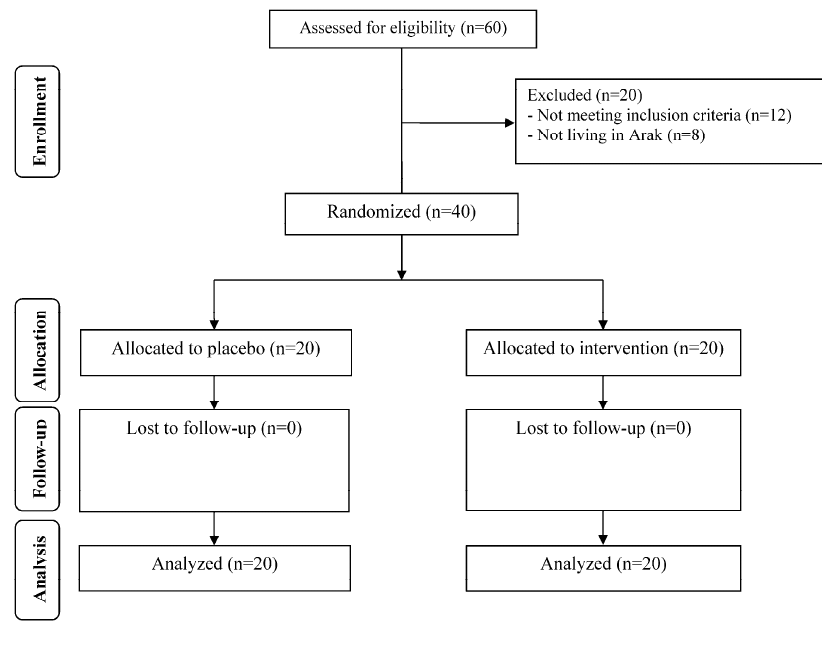
Figure 1. Summary of patient flow diagram.